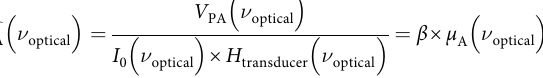
Figure 4c, d show the result of normalizing the polymers ’ PA responses according to Eq. (4). For comparison, these fi gures also show the optical absorbance spectra, ∝ μ A ( v optical ), of PDMS and